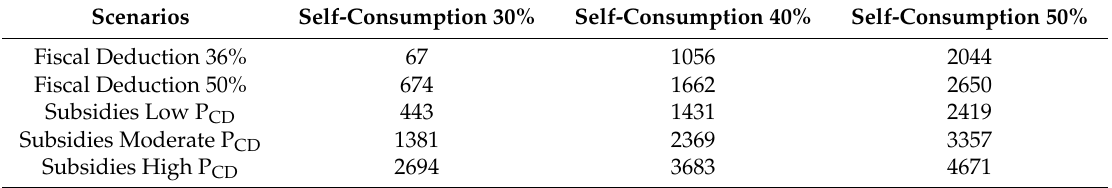
Table 9. NPV in alternative scenario (C inv,unit = 1700 € /kW). Data expressed in € .